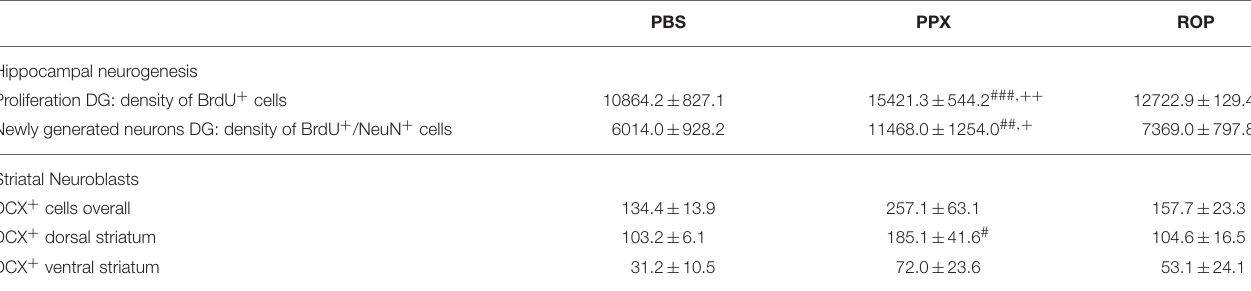
TABLE 1 | Summary of PPX and ROP treatment on hippocampal and striatal neurogenesis.